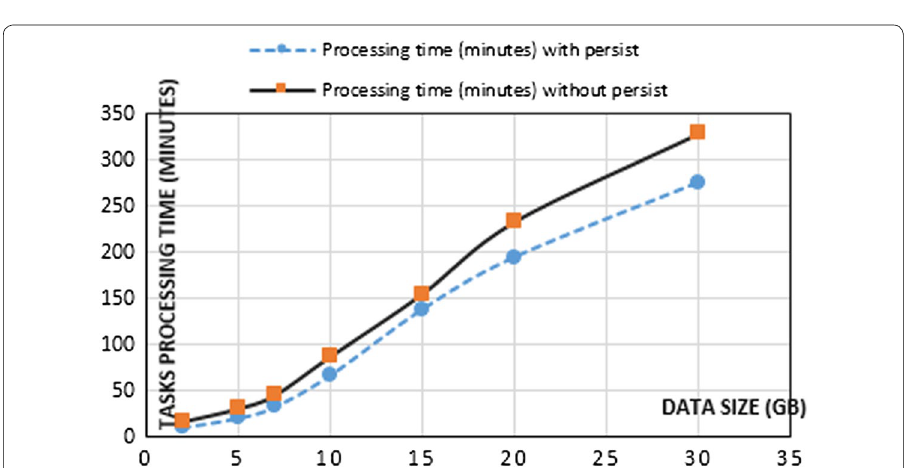
Fig. 10 Performance comparison between caching and non‑caching data: also, caching improves the performance. Caching stores big part of the data in‑memory, which accelerate the